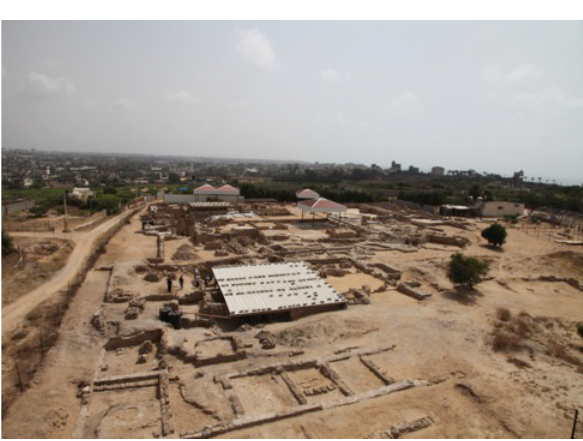
Figure 2: Partial view of achaeological